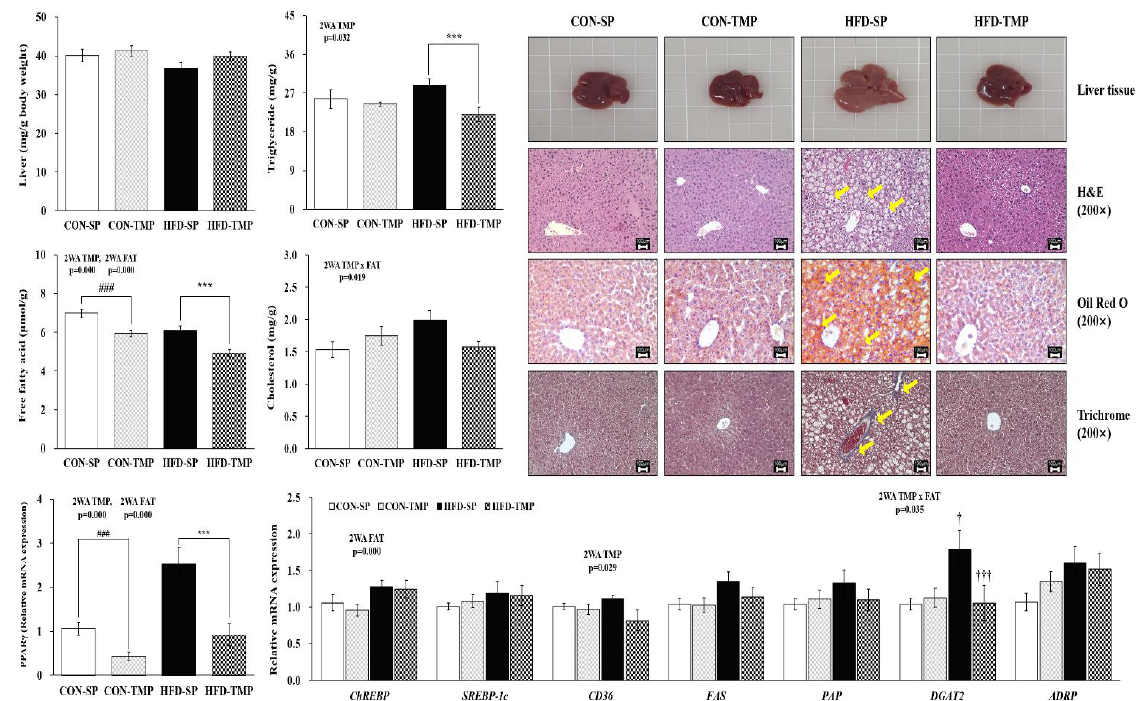
Figure 3. Histology, lipid contents, and lipid metabolism-related gene expression in the liver. The values are expressed as the means ± S.E. (n = 10 per group). † vs. CON-SP and ††† vs. HFD-SP by two-way ANOVA followed by a Turkey post hoc test ( p < 0.05). ### p < 0.001 vs. CON-SP, *** p < 0.001 vs. HFD-SP by Student’s t -test. Histological analysis magnification 200×. Yellow arrows indicated the lipid droplets or fibrosis. 2WA FAT, fat diet effect in two-way ANOVA ( p < 0.05); 2WA TMP, TMP effect in two-way ANOVA ( p < 0.05); 2WA TMP × FAT, interaction between TMP and fat diet in two-way ANOVA ( p < 0.05); CON-SP, control diet containing SP; CON-TMP, control diet containing TMP; HFD-SP, high-fat diet containing SP; HFD-TMP, high-fat diet containing TMP; H&E, hematoxylin and eosin.